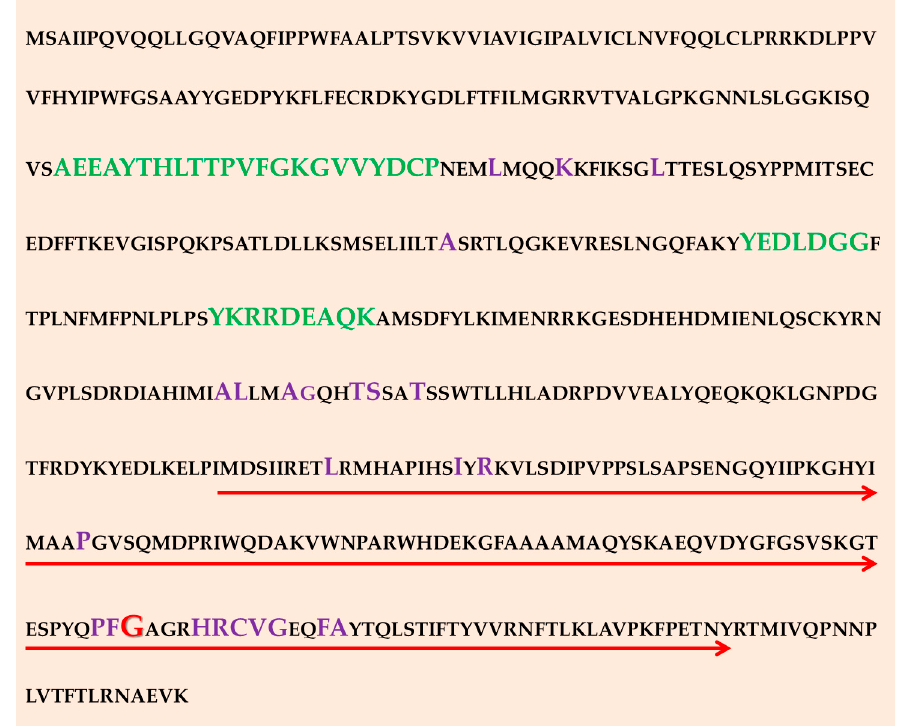
Figure 1. Sequence logo showing the SNPs within the C. neoformans ERG11 gene.